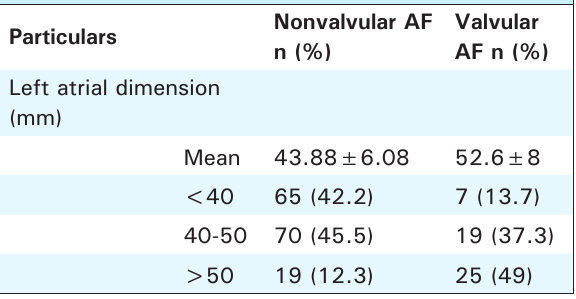
Table 4. Echocardiographic left atrial dimension in patients with atrial fibrillation.